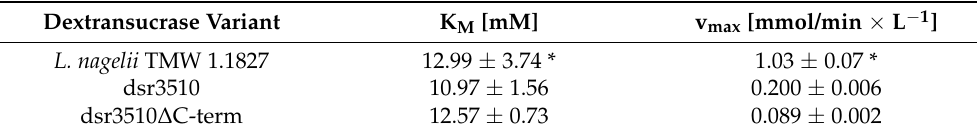
Table 1. Michaelis constants (K M ) and maximum reaction rates (v max ) of the native extracellular dextransucrase of L. nagelii TMW 1.1827, as well as the heterologously expressed dextransucrase variants dsr3510 and dsr3510 ∆ C-term at pH 5.0 and 30 ◦ C. Reaction mixtures of heterologously expressed variants contained 1 mM CaCl 2 . Values are given ± SD. * Adapted from Bechtner et al. [31]. Dextransucrase